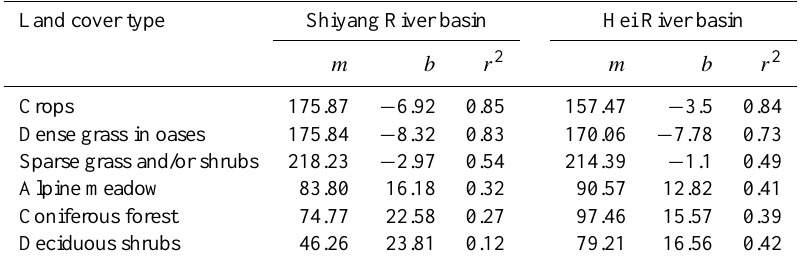
Table 3. Regression fits ( y = mx + b ; m = slope and b = y intercept) and their associated coefficients of determination ( r 2 ) for comparisons between basin-level monthly evaporation over a 10-year period (2000–2009) as a function of same-month enhanced vegetation index for different vegetated-cover types (subset of land cover types in Table A1 and Fig. 1). Vegetated-cover types are ordered according to their position in the basins (Fig. 1), starting with vegetation types in zone 1 ( < 2500ma.m.s.l.).